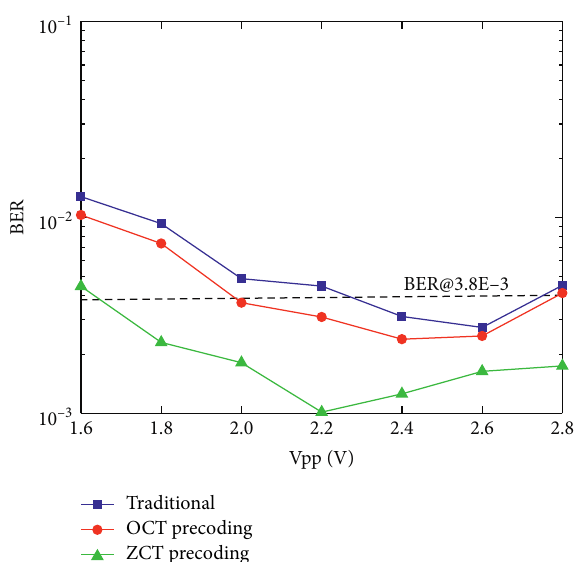
Figure 7: BER versus Vpp (DC � 2.1V).